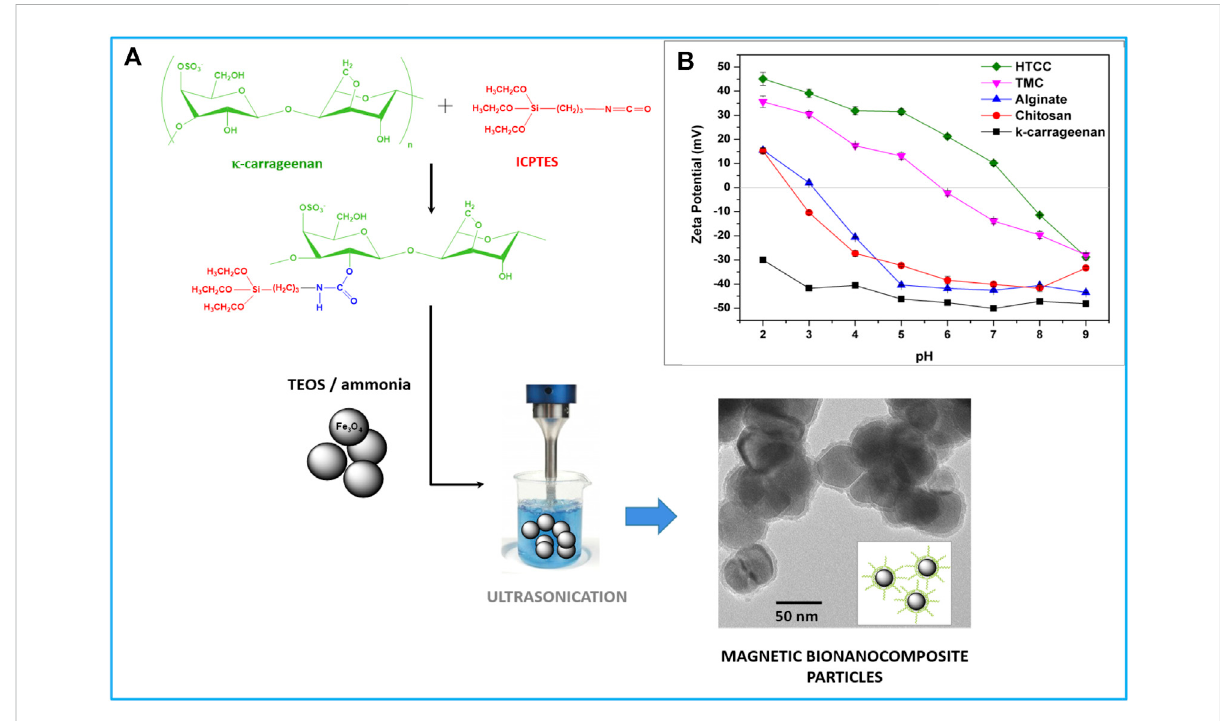
FIGURE 2 (A) Schemeillustratingthechemicalroutetopreparethesiliconalkoxidederivativeofthebiopolymerk-carrageenanandthepreparationofthe magnetic biosorbents through coating the Fe 3 O 4 nanoparticles with the bio-hybrid siliceous shell; (B) Potential zeta values of magneticbiosorbents prepared using distinct biopolymers (HTCC -N-(2-hydroxypropyl)-3-trimethylammonium chitosan; TMC-